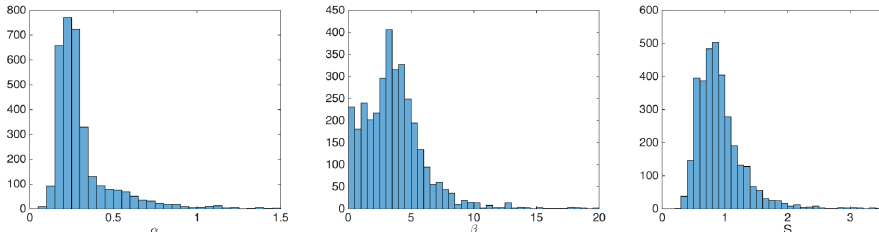
Figure B2. Same as Fig. B1 but for MYI.